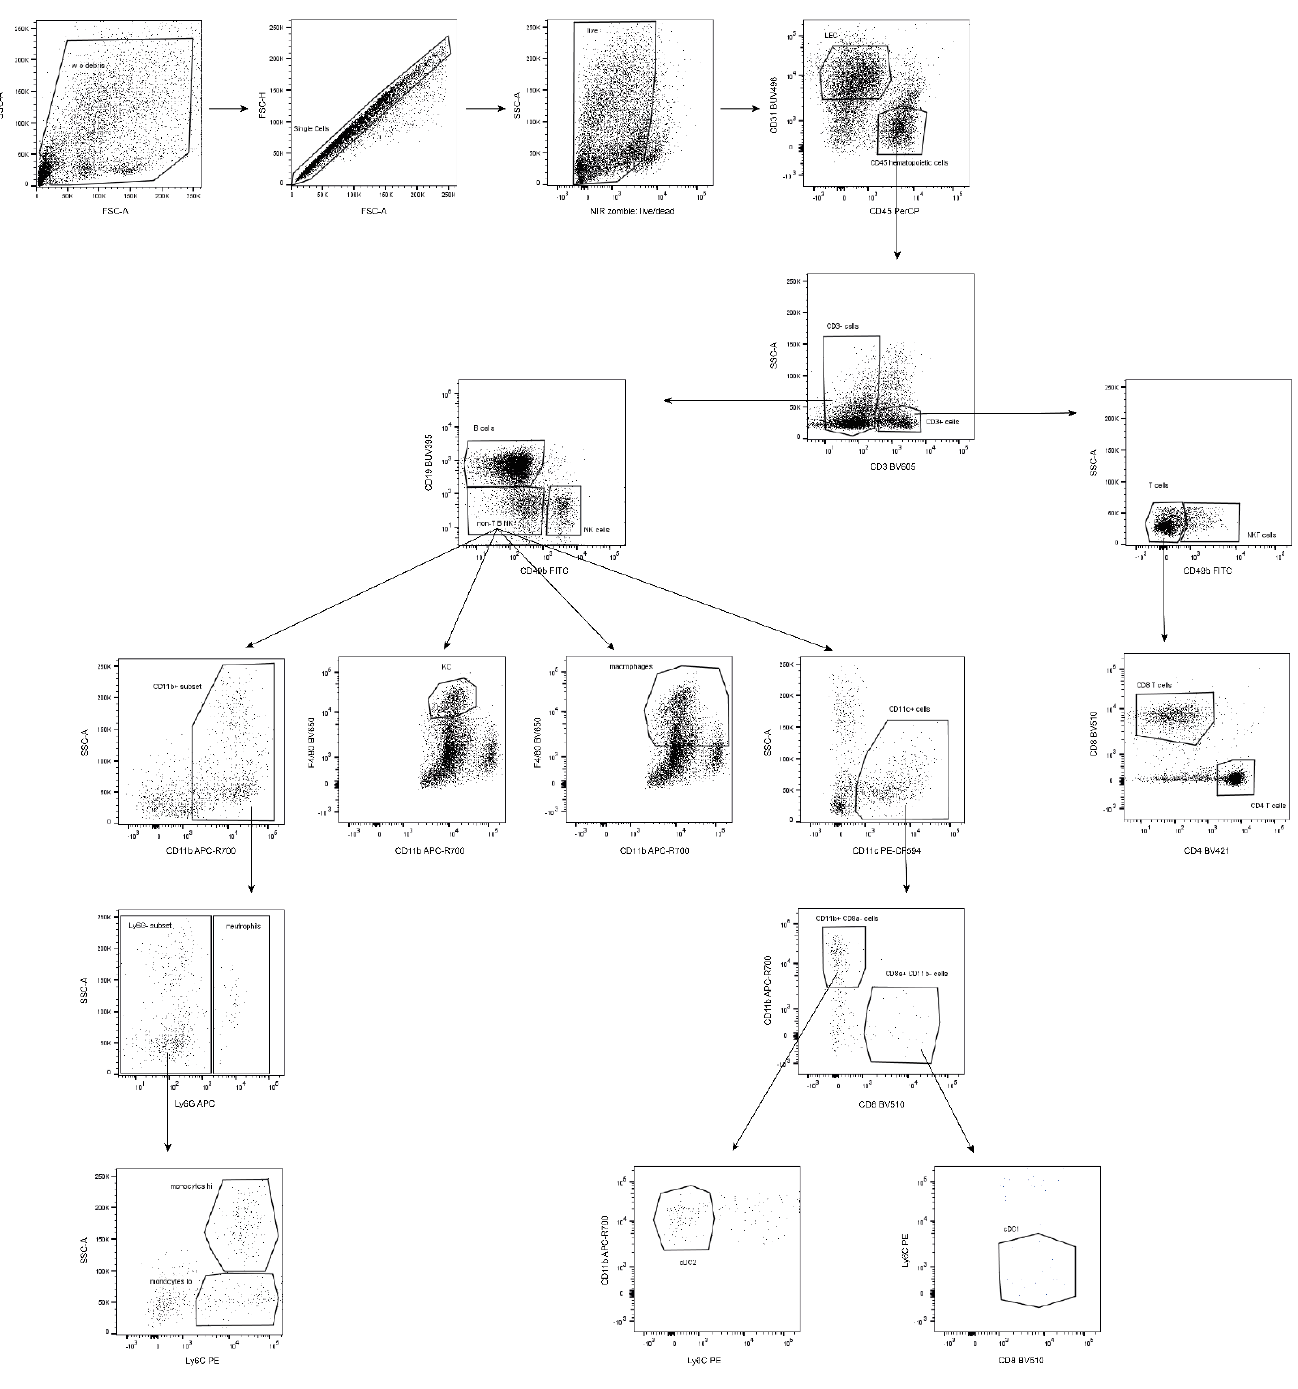
Figure 5. Illustration of gating strategy for individual immune populations. (Shown images represent a composition of three independent measurements).